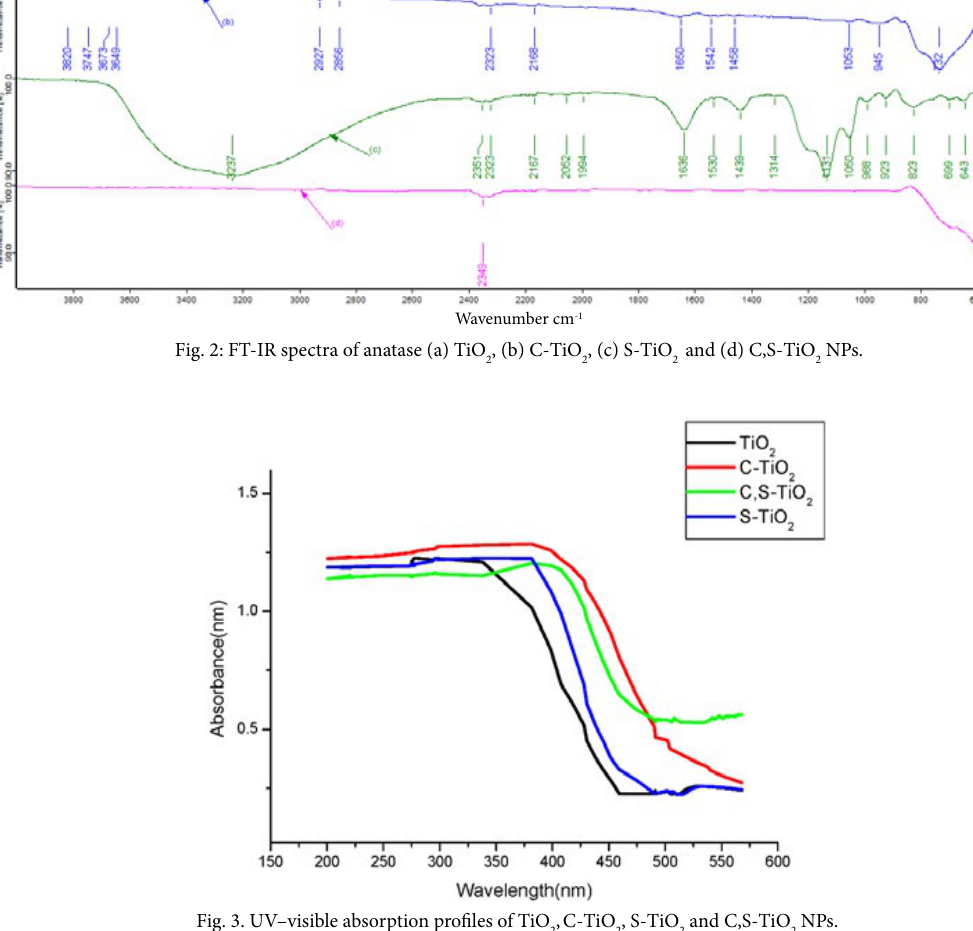
, C-TiO , S-TiO and C,S-TiO 2 2 2 2